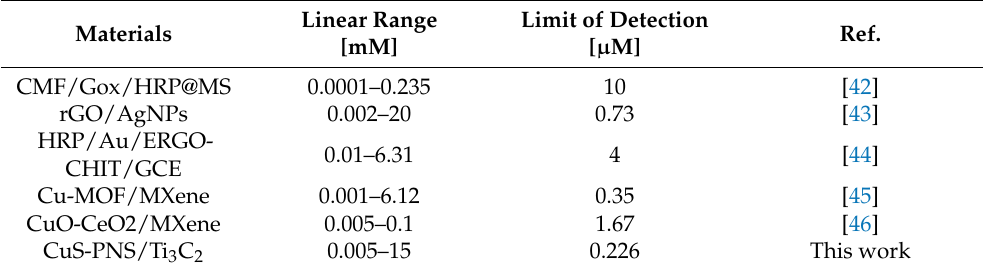
Table 1. Comparison of the sensing performances of various electrochemical H 2 O 2 sensors. Linear Range Limit of Detection Materials Ref. [mM] [ µ M] CMF/Gox/HRP@MS 0.0001–0.235